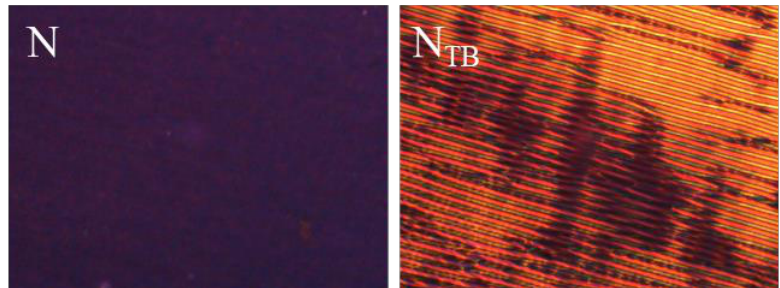
Figure 12. POM textures of the CB6OBA:1OB6OS mixture in the nematic phase (left) and twist-bend nematic phase (right).